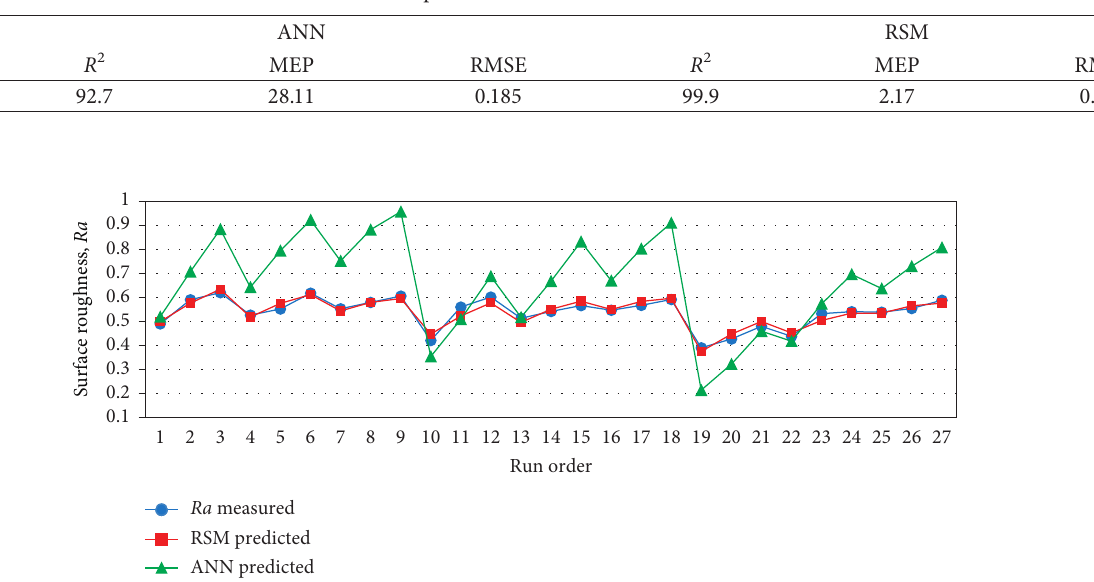
Figure 8: Experimental data versus the predicted ANN and RSM data for surface